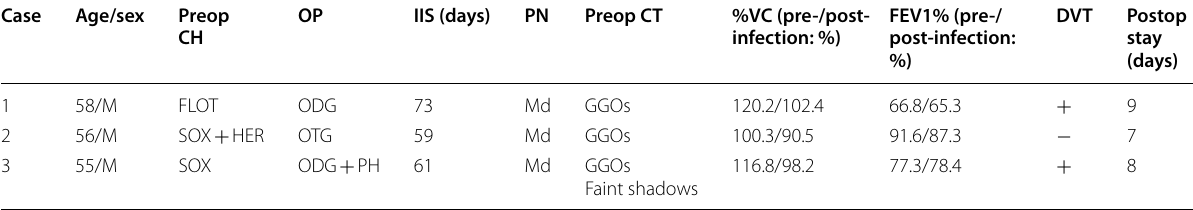
Table 1 Summary of the patients’ characteristics in the three